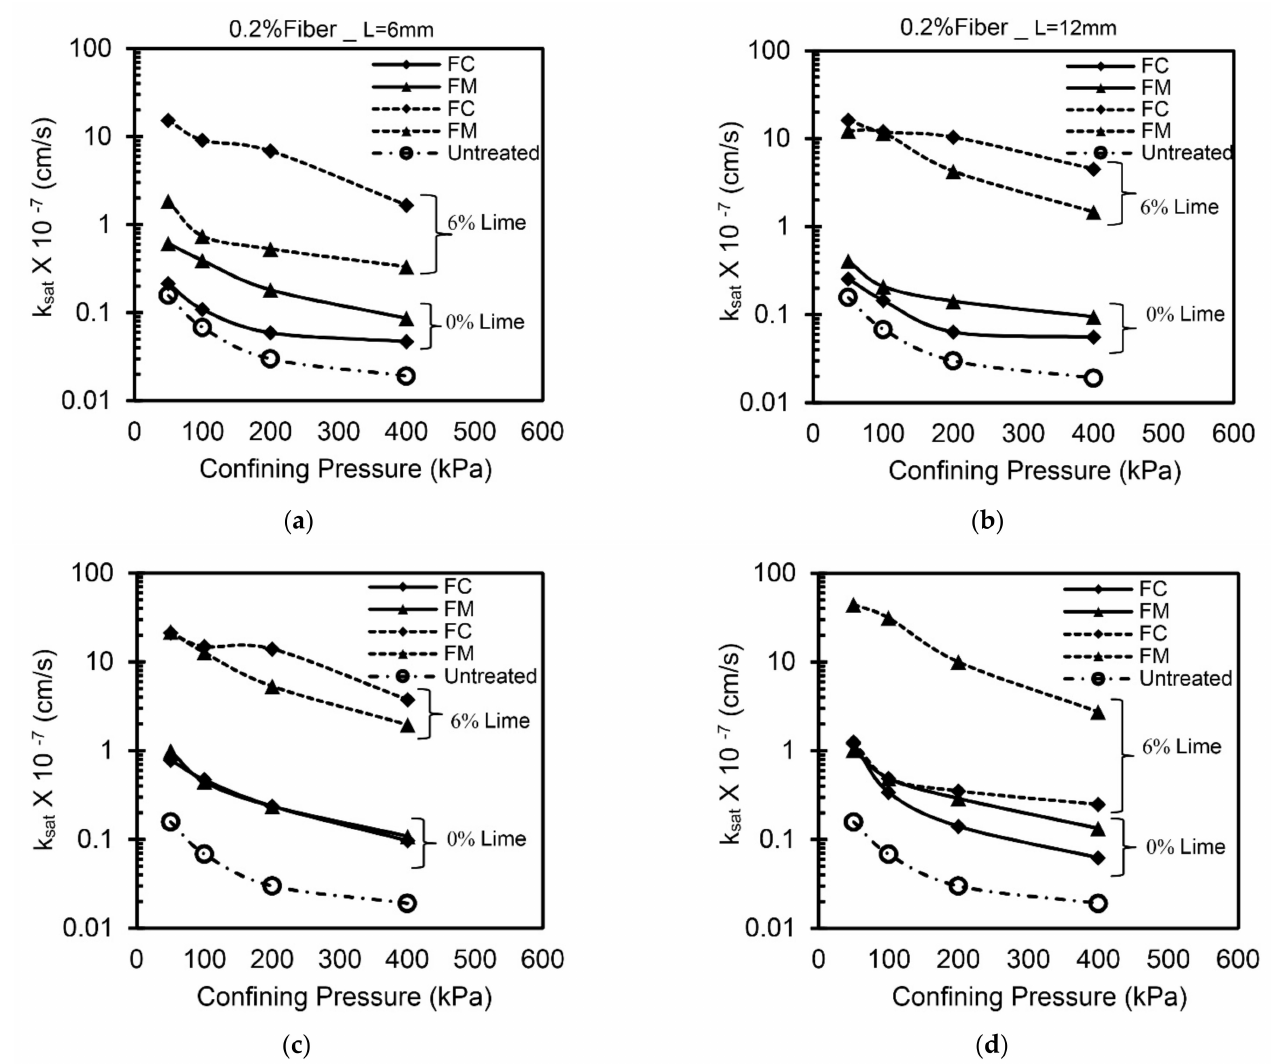
Figure 7. Variation of saturated hydraulic conductivity with lime content and confining pressure ( a ) 0.2%, 6mm; ( b ) 0.2%, 12mm; ( c ) 0.6%, 6mm; ( d ) 0.6%,